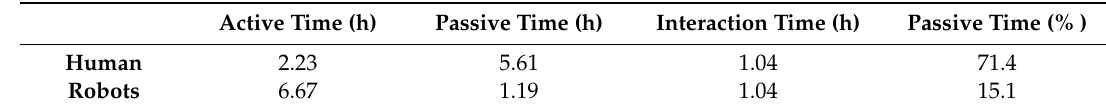
Table 5. Working time detail for human and robot in HRI